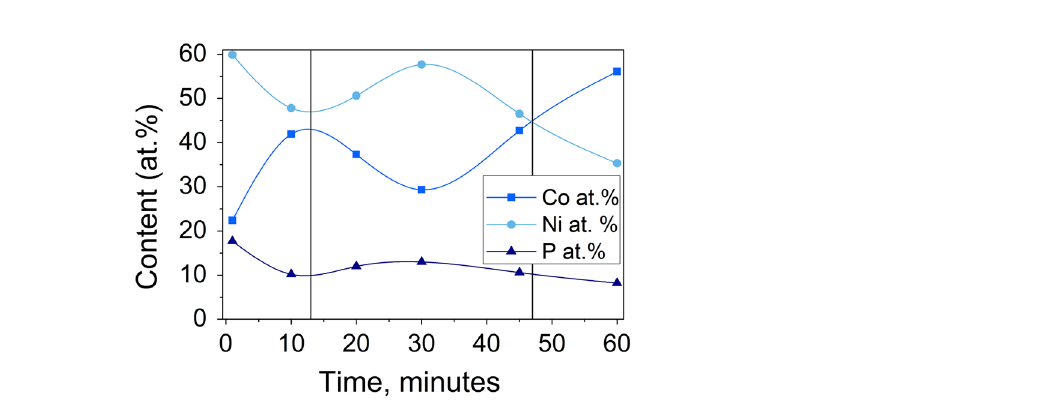
Figure 3. Chemical composition of CoNiP